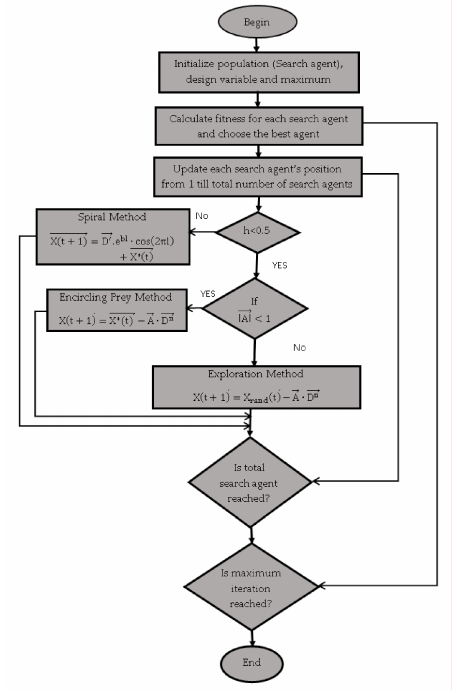
Figure 5. Flowchart of the whale optimization